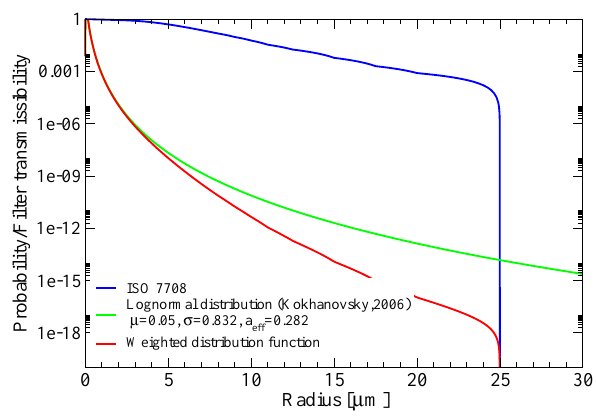
Fig. 6. Filter functions for the conversion between the different Fig. A6. Filter functions for the conversion between the different definitions of particulate matter mass load. The red curve denotes definitions of particulate matter mass load. The red curve denotes the weighted distribution function which is a folding of the log- the weighted distribution function which is a folding of the log- normal distribution with the I SO 7708 weighting function. normal distribution with the I SO 7708 weighting function.